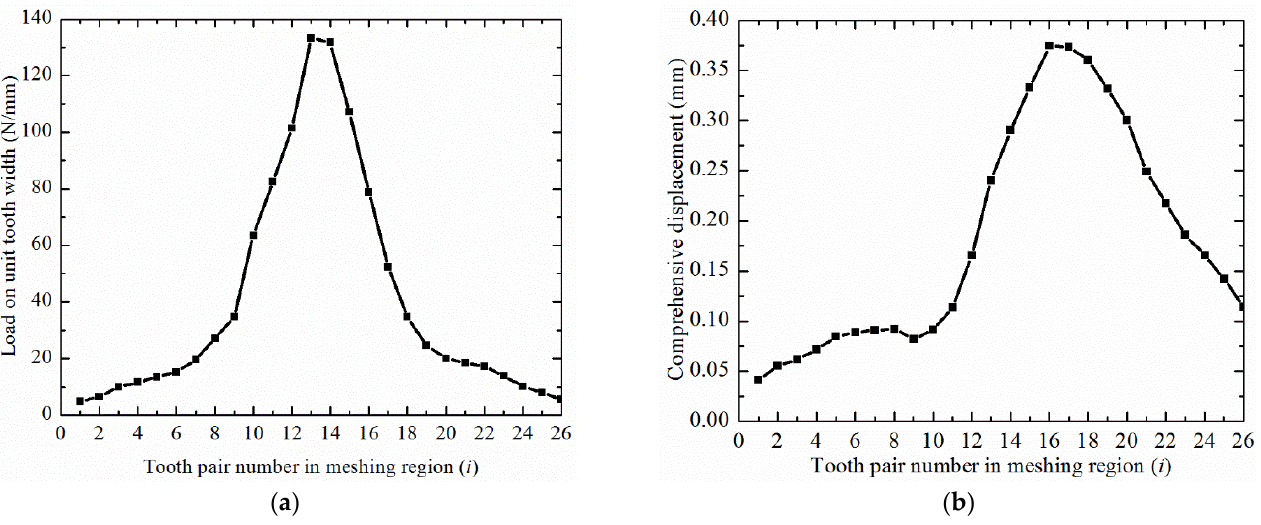
Figure 26. ( a ) Load on the unit tooth width of each node in the meshing region; ( b ) comprehensive displacement of each node in meshing region in case of overload.